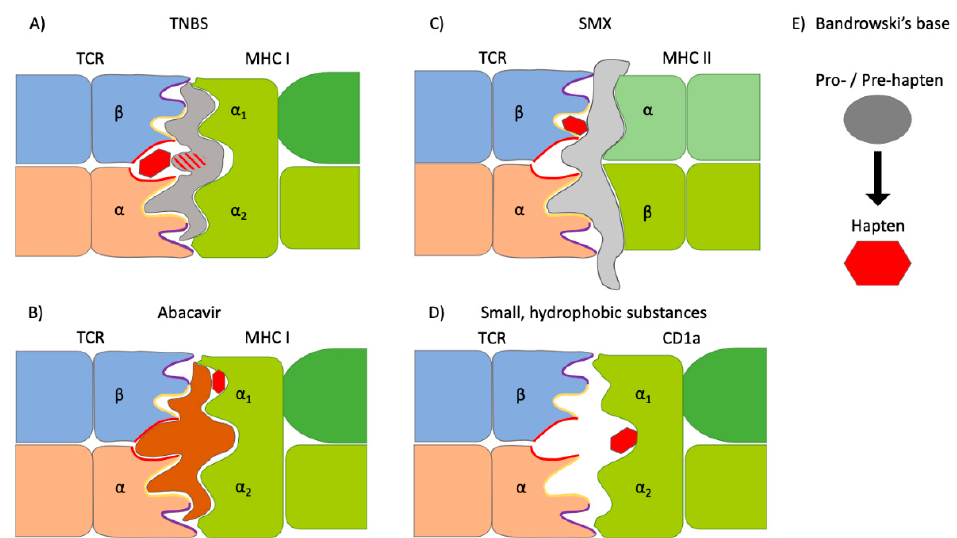
Figure 1. Mechanisms of T cell receptor (TCR) activation by non-metallic chemical allergens. ( A ) Chemical haptens (red trapeze) may bind covalently to major histocompatibility complex (MHC)- presented peptides (hapten concept). This has been shown for MHC I-restricted CD8+ T cells specific for the model chemical 2,4,6-trinitrobenzenesulphonic acid (TNBS) or the β -lactam antibiotic flu- cloxacillin. Murine responses seem to focus on a lysine modification at peptide position 4 (red-grey striped) [44,45]. ( B ) Some drugs associated with hypersensitivity reactions bind non-covalently, which is called pharmacological interaction (p-i) [46,47]. Binding via p-i has often been described in association with certain MHC alleles, termed human leukocyte antigens (HLAs) in humans (green). Abacavir, for example, binds to the F-pocket of HLA-B*57:01 resulting in the presentation of altered peptides (brown) [48,49]. ( C ) Some chemicals and metal ions form complexes at the TCR-pMHC interface. For sulfamethoxazole (SMX), binding to the complementarity-determining region 2 (CDR2) of TRVB-20-expressing TCR (blue) has been modeled [50]. ( D ) Haptens may displace endogenous lipid ligands on the MHC-like molecule cluster of differentiation (CD) 1a resulting in polyclonal αβ TCR activation to the CD1a surface [51]. ( E ) Pro- or pre-haptens require auto-oxidation or processing by metabolizing enzymes to become protein-binding.